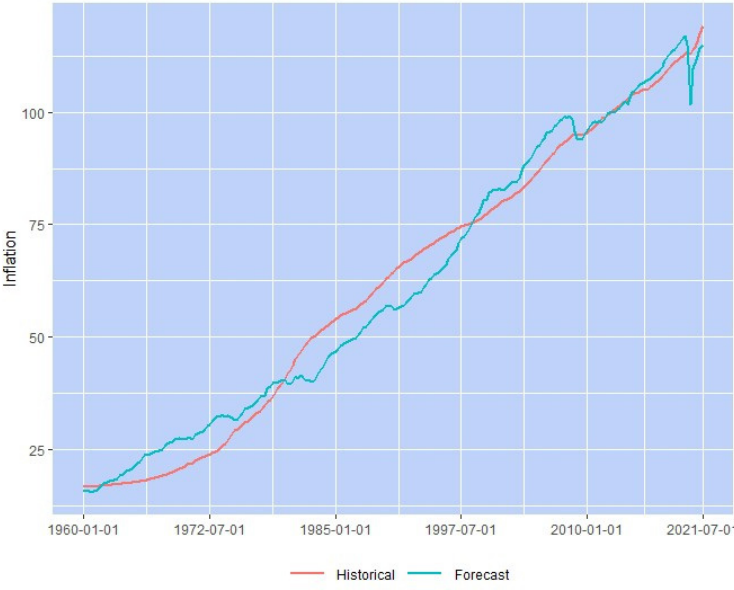
Figure 1. Inflation as a functional of money stock, velocity, and GDP. Table 5. Ceteris paribus numerical inflation scenarios.